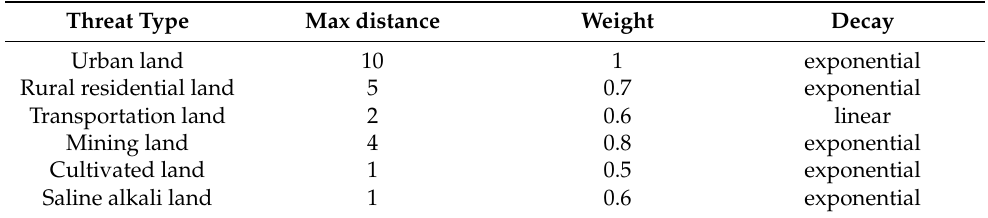
Table 6. Threat factors and weight in the study area.